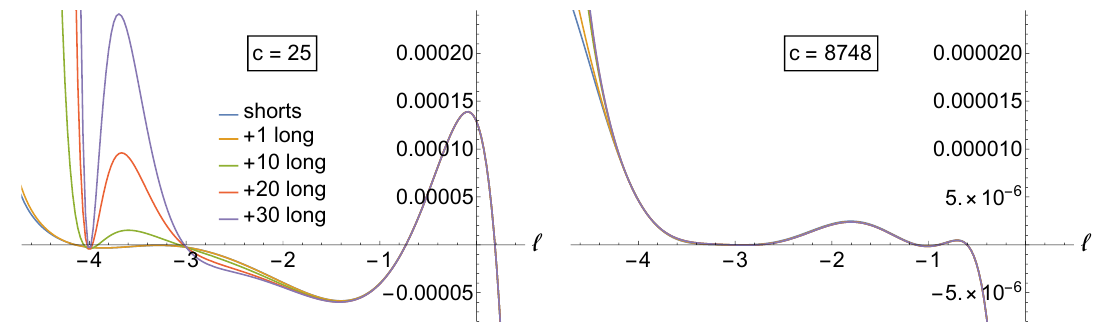
Figure 7. We plot a crude estimate of c (∆ , ‘ ) | phys as a function of ‘ with ∆ = 3 + 10 − 5 and with c = 25 (left) and c = 8748 (right). The slight displacement from the shadow symmetric line at ∆ = 3 is simply for faster numerics. Here c (∆ , ‘ ) | 3) c (∆ , ‘ ) / [ κ Γ(( ‘ + ∆ + 1) / 2)Γ(( ‘ + 6 − ∆ + 1) / 2)] is just the c (∆ , ‘ ) with all spurious ∆+ ‘